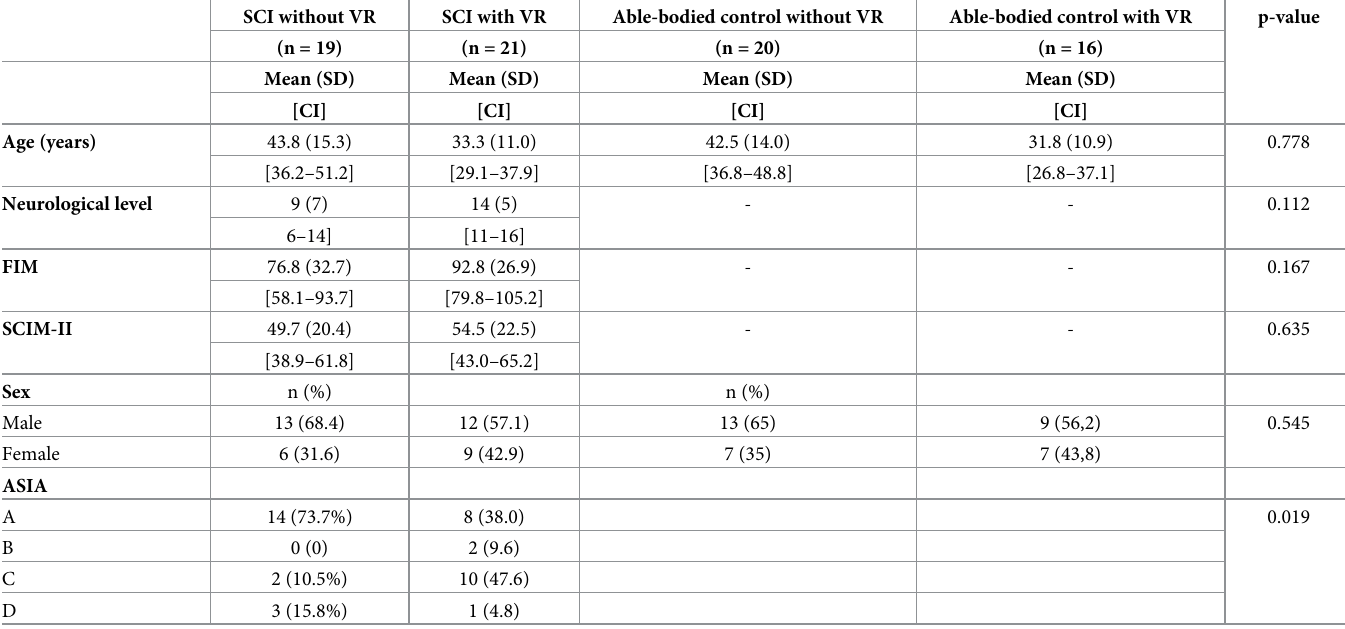
Table 1. Characterization of the